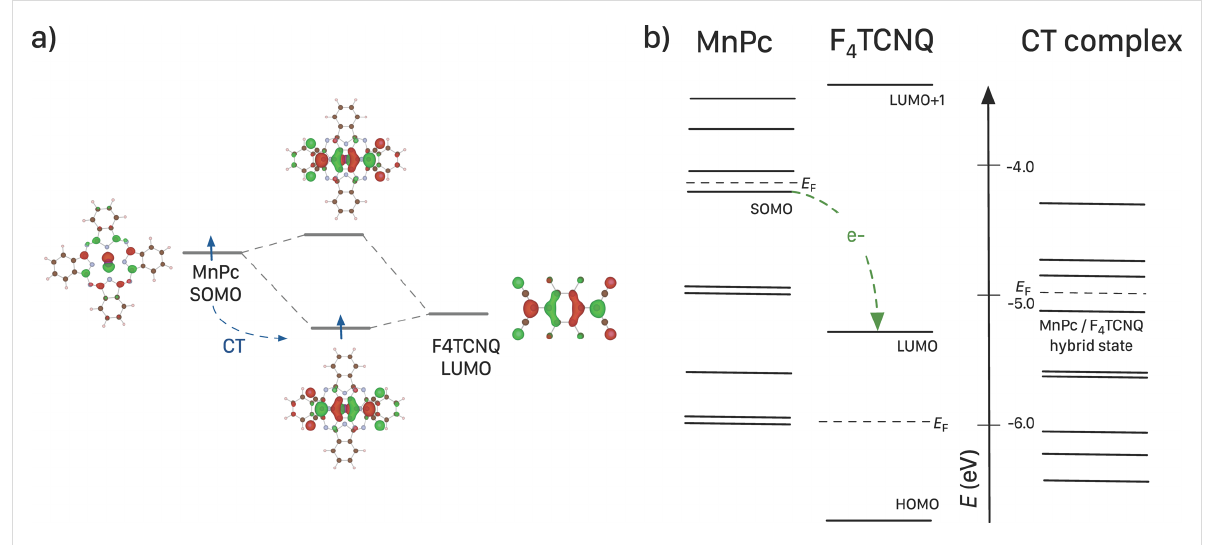
Figure 7: Results of the DFT calculations for the MnPc/F 4 TCNQ dimer model systems: a) The SOMO of MnPc and the LUMO of F 4 TCNQ hybridize and charge is transferred into the newly formed bonding hybrid state. b) Comparison of the eigenvalues of the Kohn–Sham orbitals as obtained from